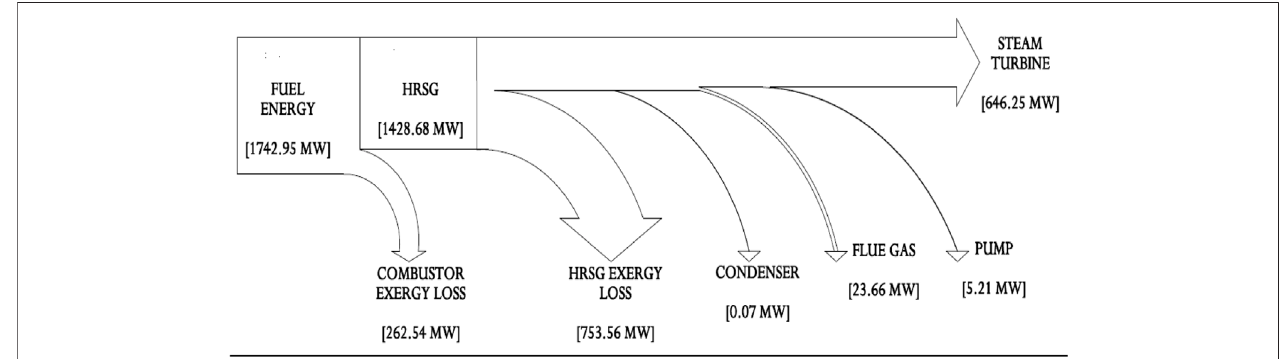
FIGURE 13 | Sankey diagram of exergy balance showing fl ow rates of